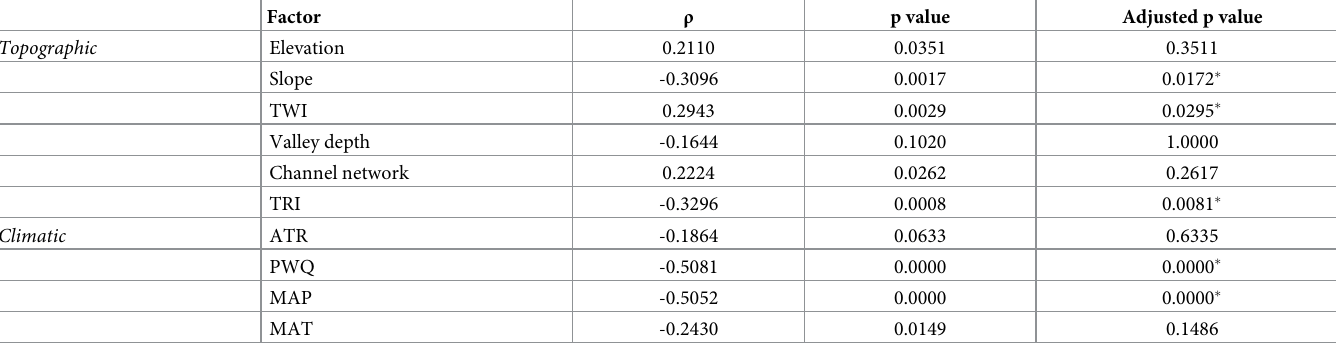
Table 2. Spearman correlations between factors and soil